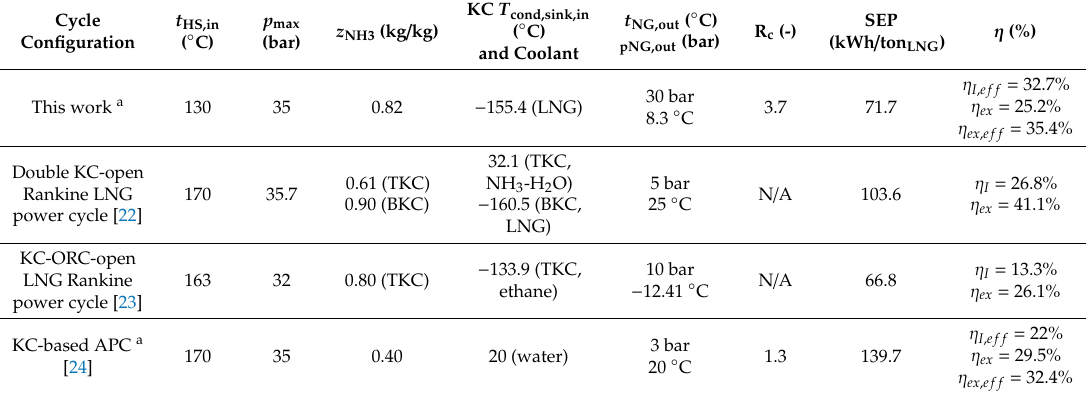
Table 5. Comparison of present poly-generation system performance characteristics with those of previously reported LNG-assisted KC-based power and dual power / cooling generation